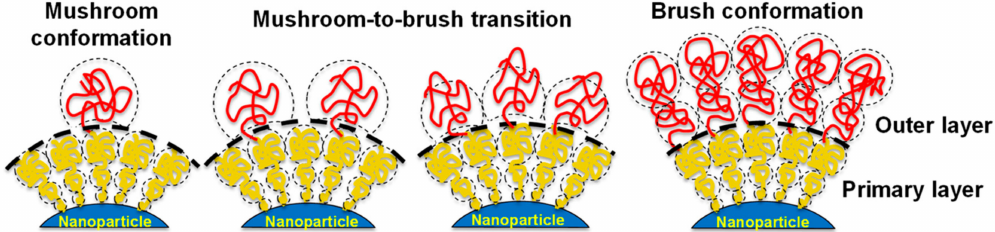
Figure 6. Polymeric nanoparticles carrying a double PEG layer with di ff erent graft densities and topographical conformations, which alter the kinetics of the interaction between the particles and proteins. Reprinted with permission from reference [49]. Copyright (2018) American Chemical